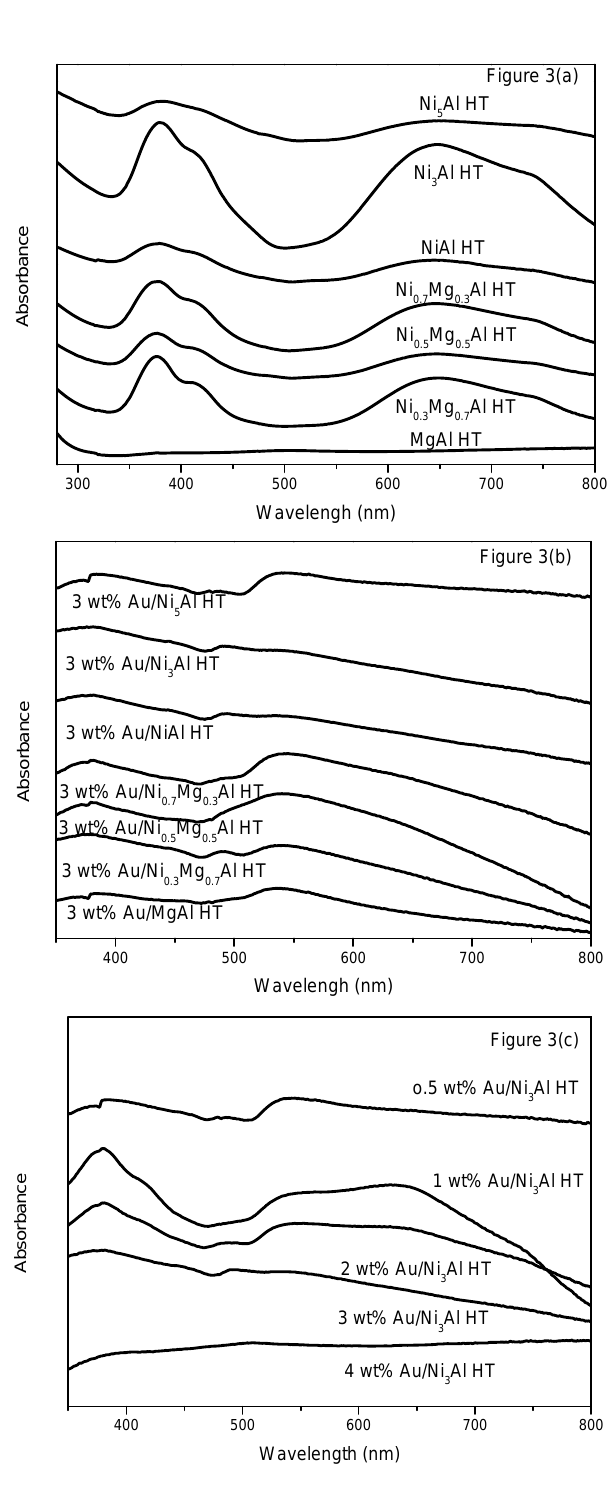
Figure 3. ( a ) UV ‐ visible diffuse reflection spectra of the different supports; ( b ) UV ‐ visible diffuse Figure 3. ( a ) UV-visible diffuse reflection spectra of the different supports; ( b ) UV-visible diffuse reflection spectra of the Au catalysts with various supports; ( c ) UV ‐ visible diffuse reflection spectra reflection spectra of the Au catalysts with various supports; ( c ) UV-visible diffuse reflection spectra of of the Au/Ni 3 Al HT catalysts with different gold loadings. the Au/Ni 3 Al HT catalysts with different gold